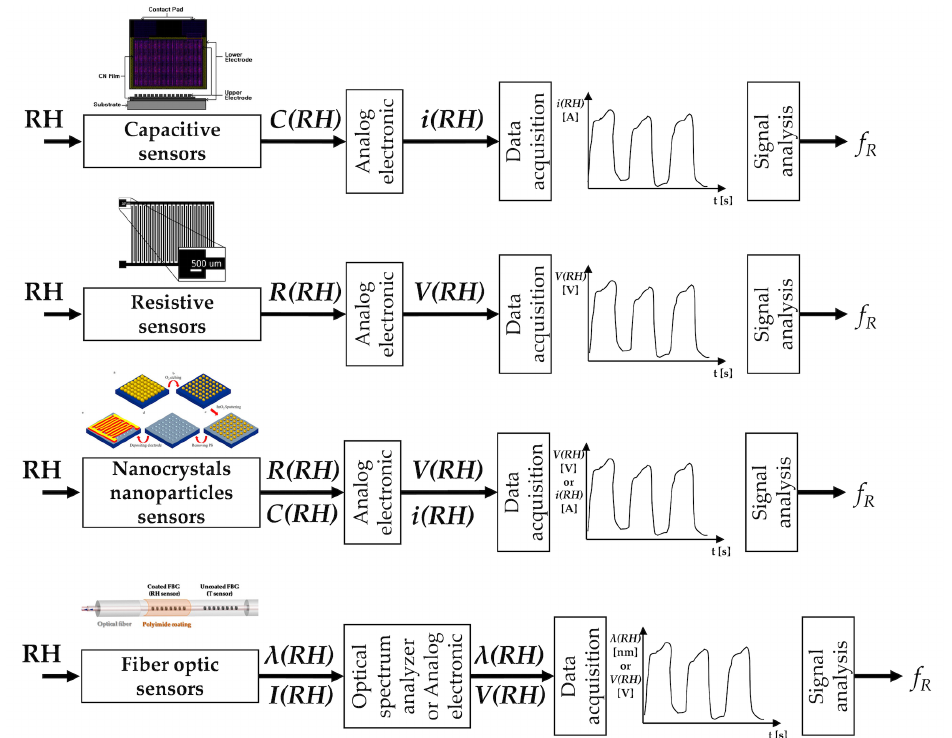
Figure 5. Relative humidity sensors: main elements composing the measuring chain (sensor, analog electronics, data acquisition, post-processing or signal analysis stage) to estimate f R . Analog electronic stages vary between different sensors since the output quantities are different. C ( RH ) , R ( RH ) , λ ( RH ) , I ( RH ) are capacitance, resistance, wavelength, and light intensity changes caused by the RH, respectively. V ( RH ) is the voltage output, i ( RH ) is the current output. The capacitive sensors picture is adapted from [112]; the resistive sensors picture is from [113]; the nanocrystals and nanoparticles sensors image is from [114]; the fiber-optic humidity sensors picture is adapted from